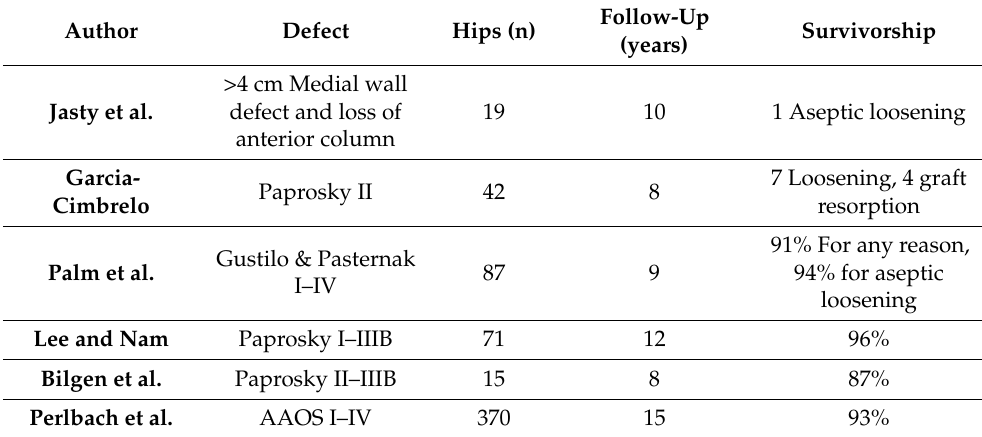
Table 1. Summary of isolated IBG